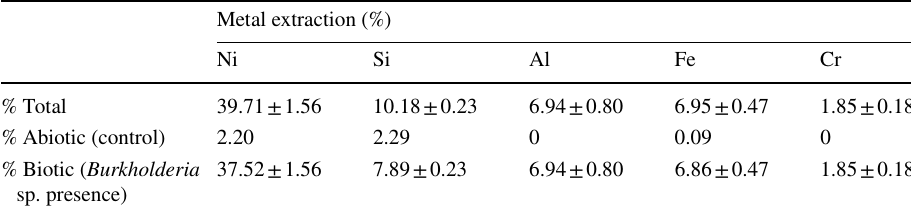
Table 4 ANOVA data for the Ni-laterite bioleaching by Burkholderia sp., and test of significance for the regression coefficients